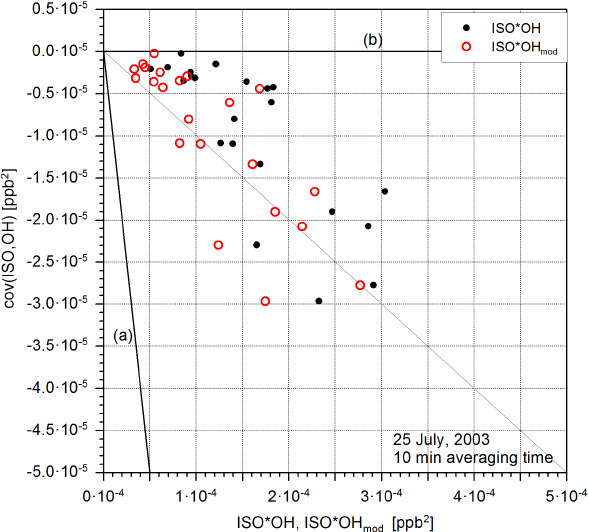
Figure 8. The covariance between isoprene and OH calculated as explained in the text as a function of product of means. The two lines (a) and (b) are explained in the text (Sect. 4.2.4).